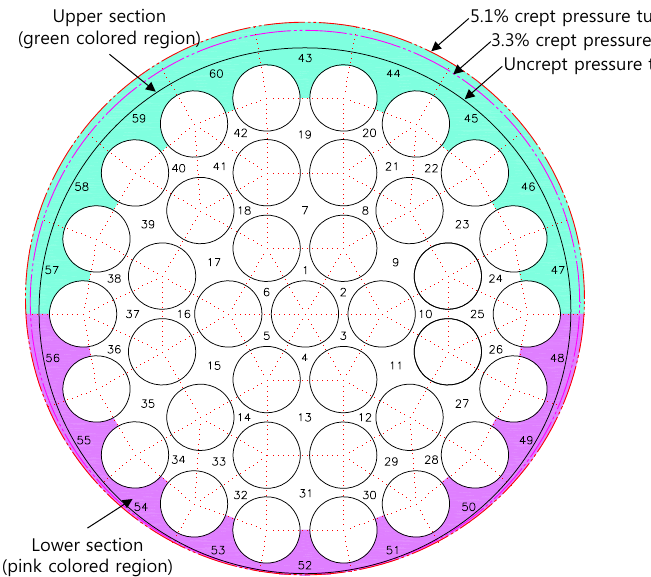
Fig. 2. Subchannel con fi guration of a 37-element fuel bundle in the crept pressure tubes.